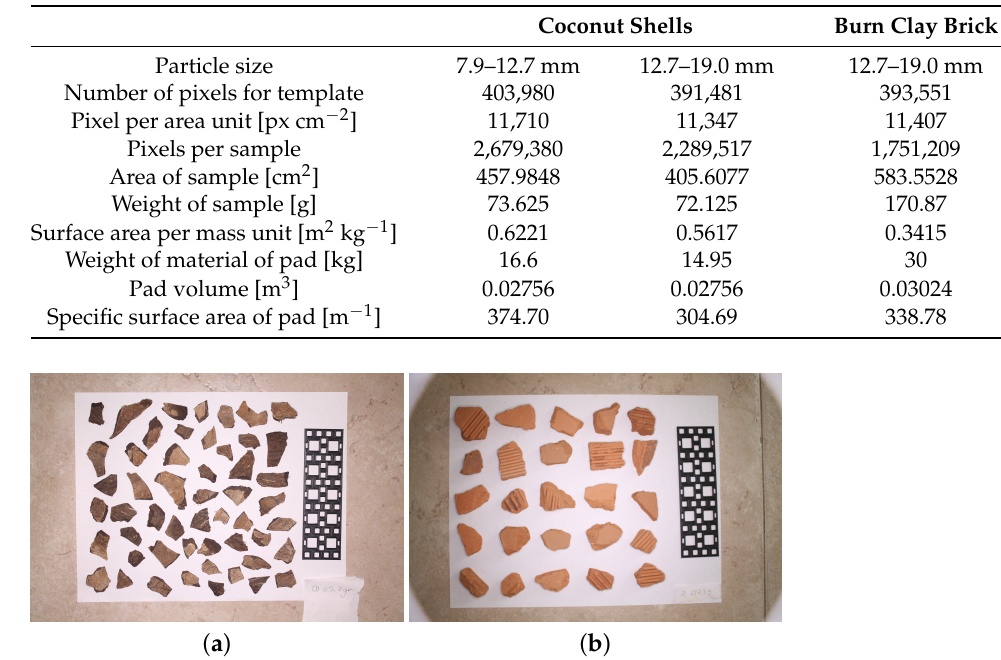
Table A1. Average data obtained through image processing of photographs samples. 32.5 cm 2 was the black area of template used.